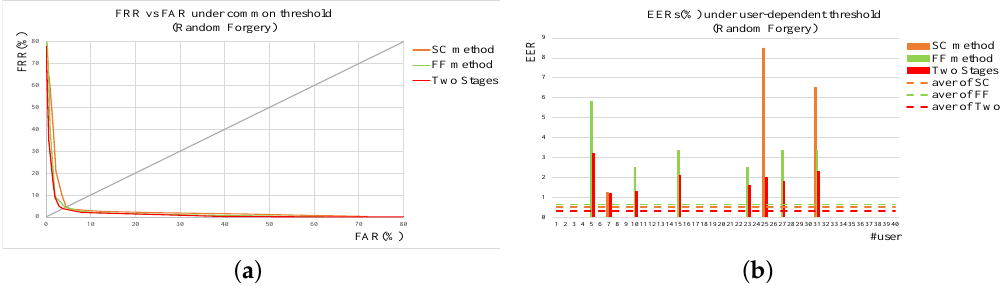
Figure 10. Results of SC, FF, and two-stage method on random forgery. ( a ) ROC under common threshold. ( b ) EER of each user under user threshold. In addition, those dotted lines are the average levels of corresponding